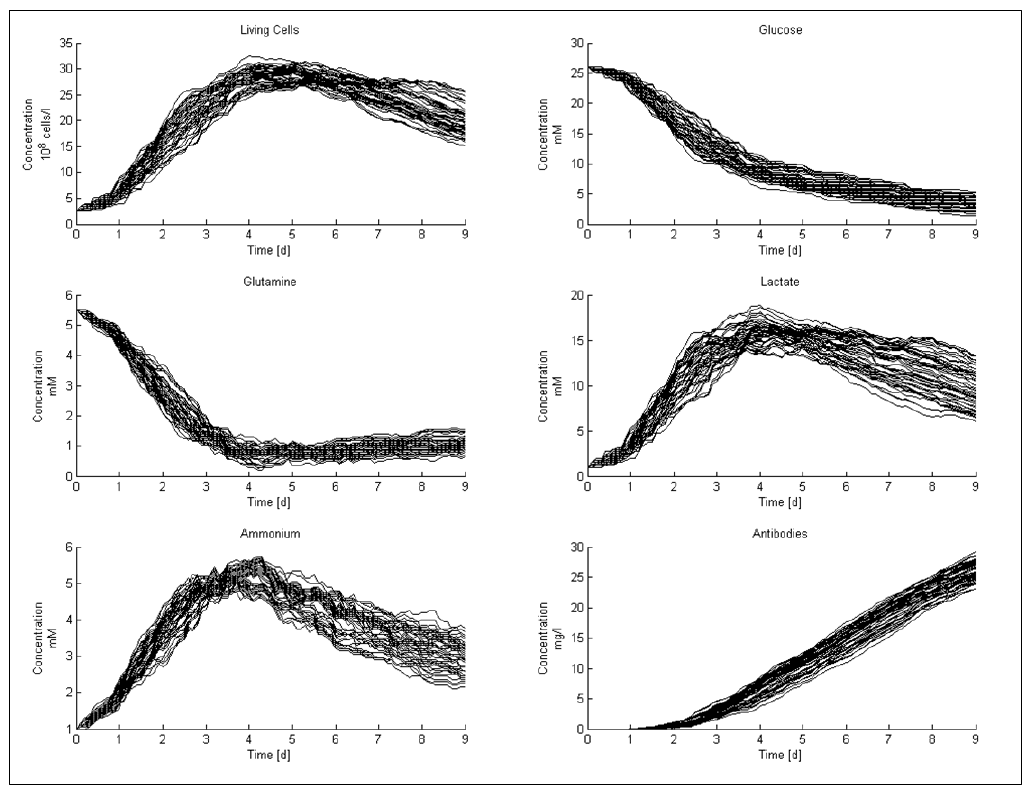
Figure 30: The stochastic simulation results according to Gillespie’s algorithm of the stochastic Petri Net model in Figure